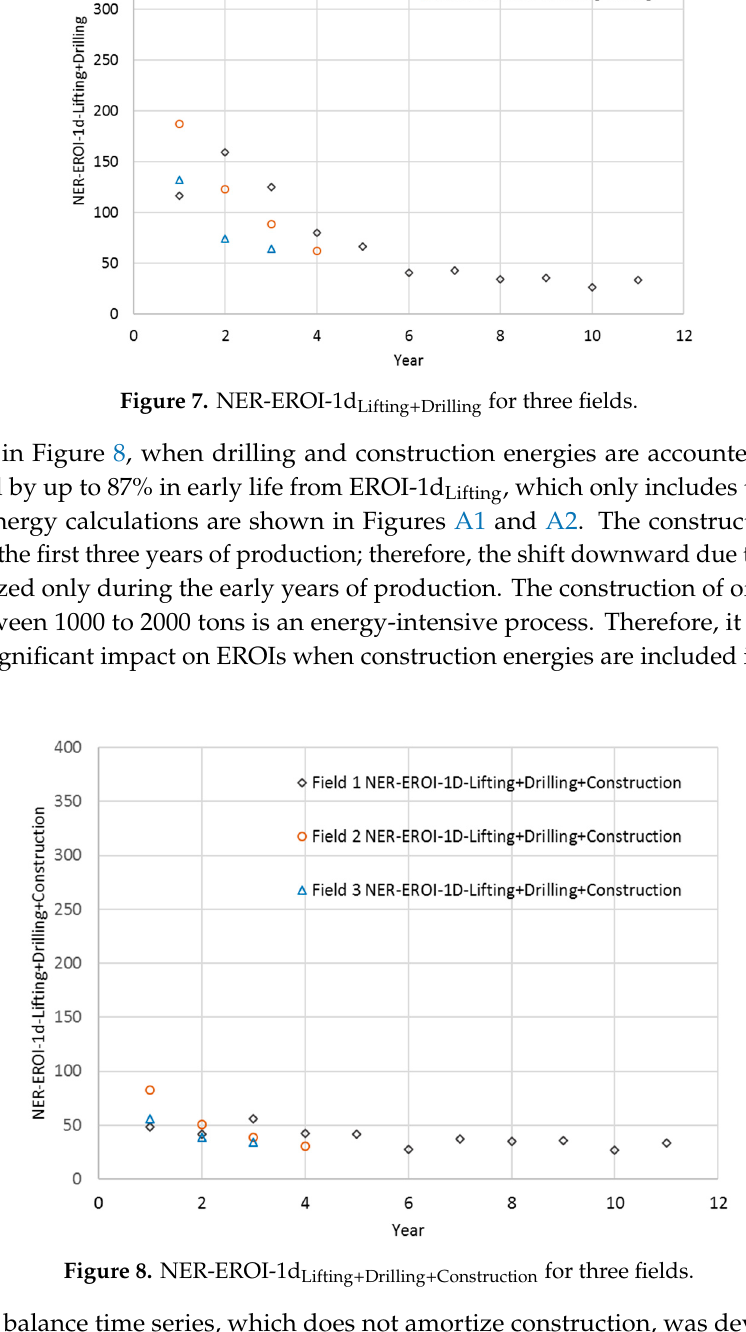
Figure 6. NER-EROI-1d Lifting regression analysis (exponential).